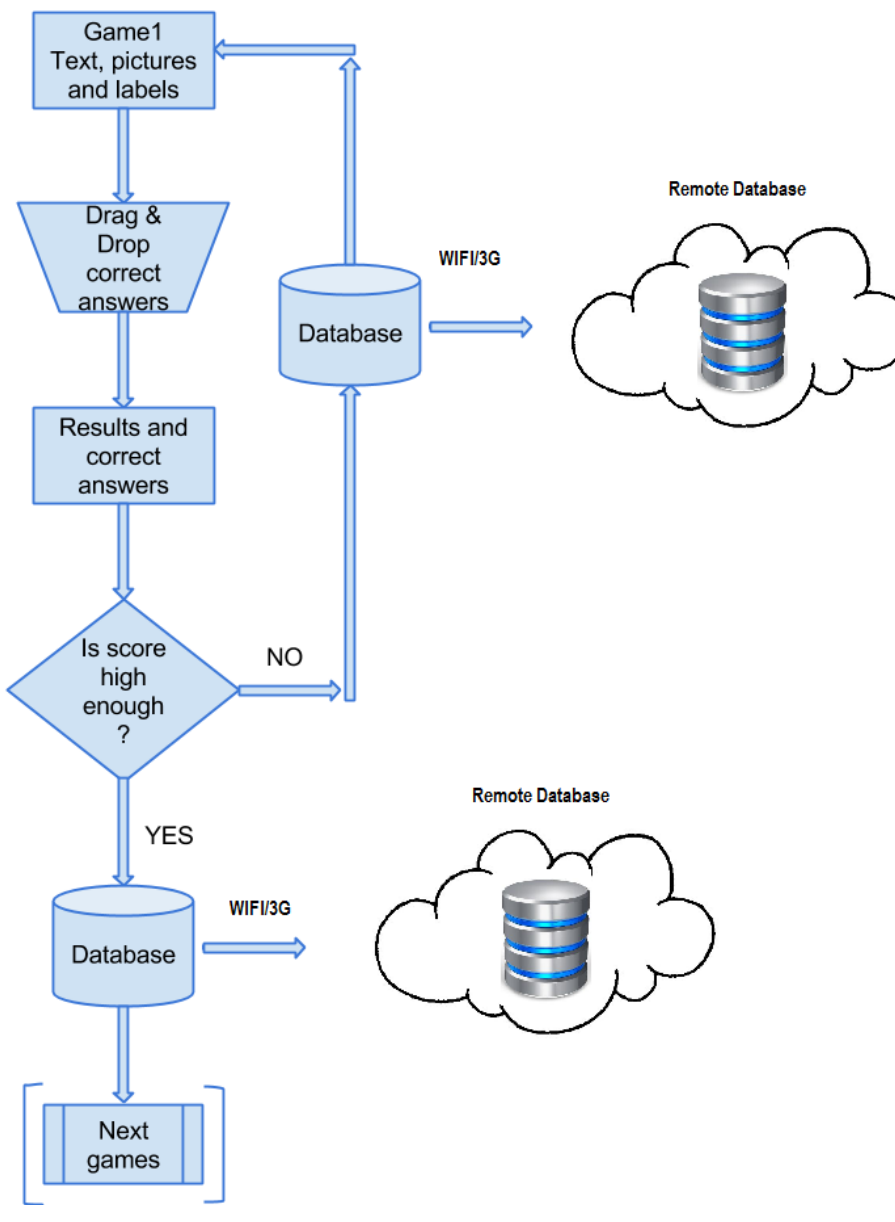
Figure 6. Process diagram of the